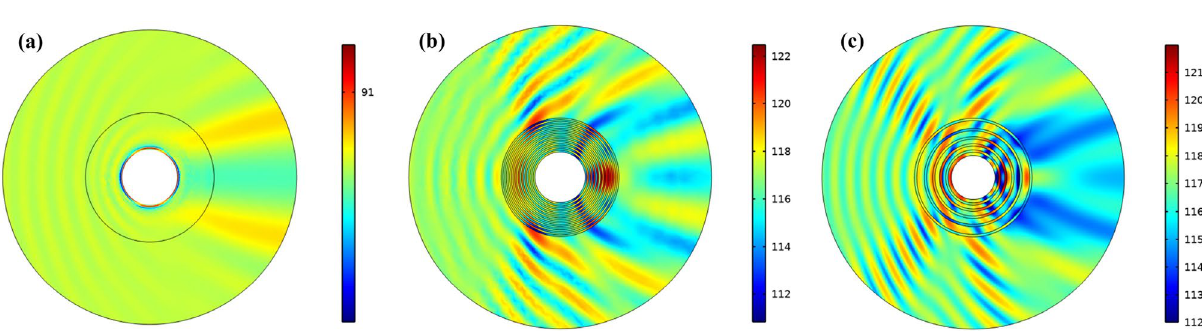
Figure 6. The total acoustic pressure field at f = 29 kHz for ( a ) homogeneous cloak with anisotropic materials, ( b ) multi-layer cloaking with 20 layers and ( c ) composite lattice cloaking with 10 layers of variable thickness.